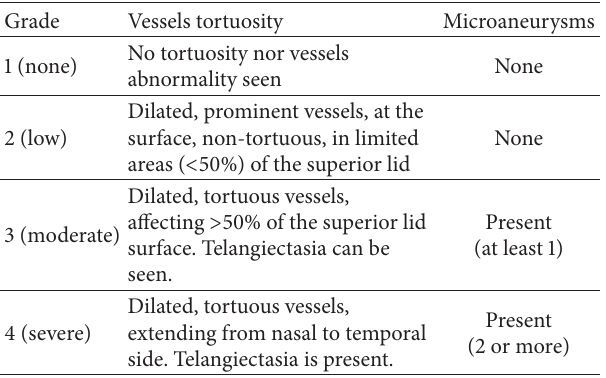
Table 1: Grading scale proposed for blood vessels tortuosity of the upper eyelid.